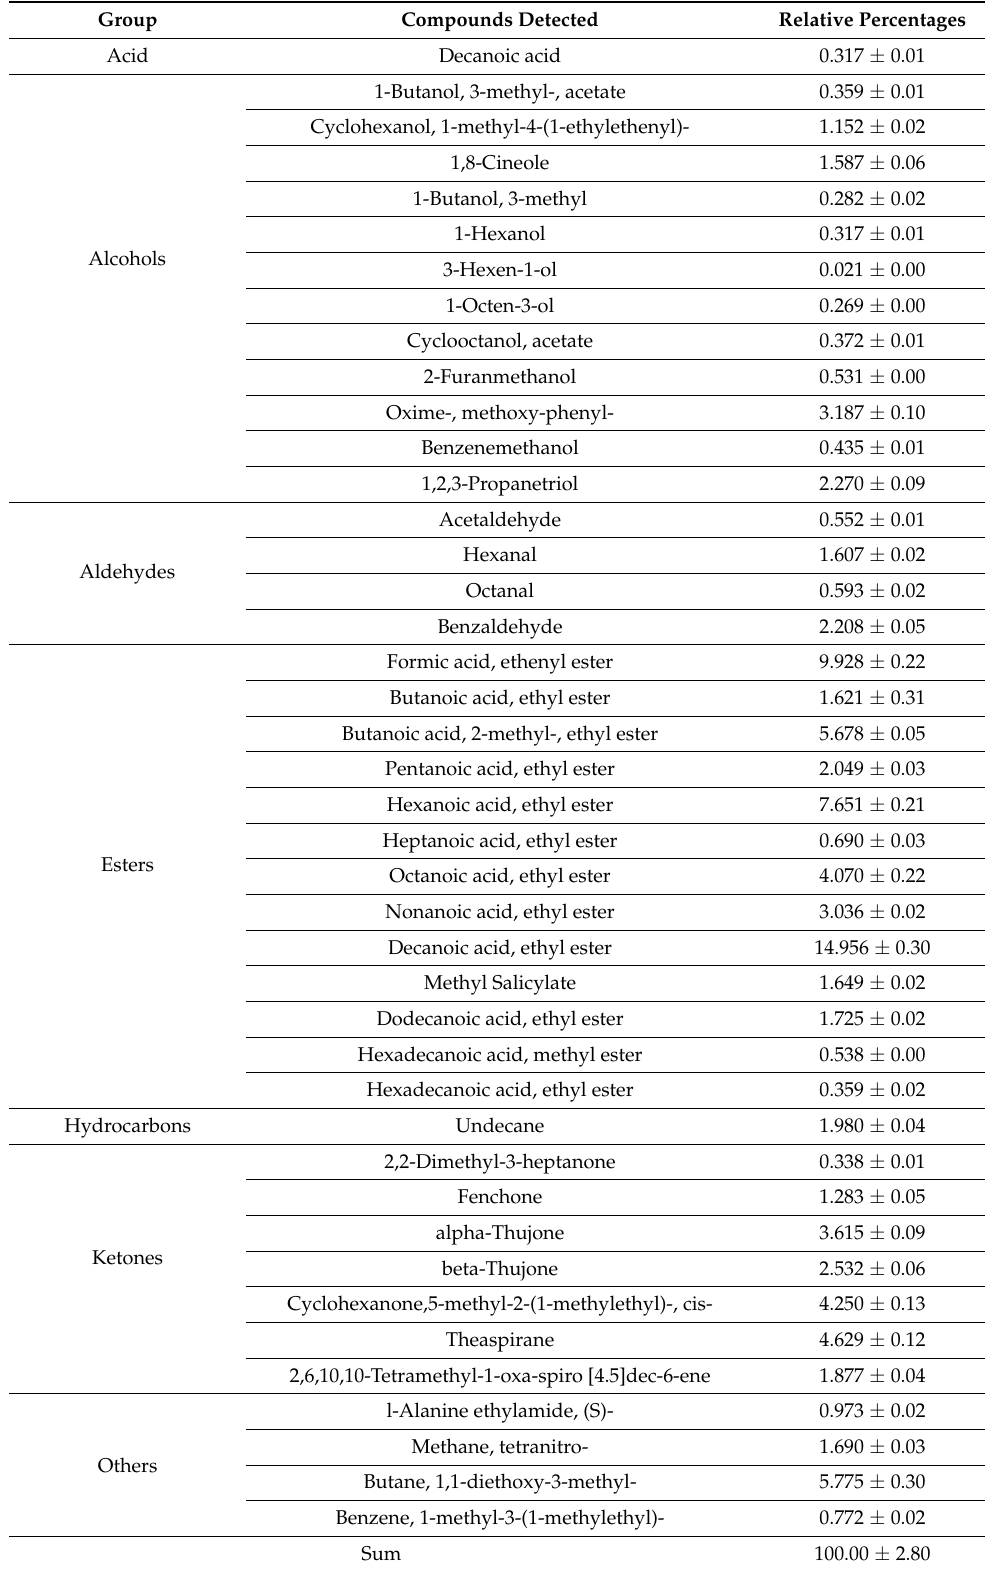
Table 1. Relative percentages of volatile compounds in ethanol–water mistletoe macerate. Mistletoe (40 g/L) was macerated in an alcoholic strength of 40% over 28 days ( n =